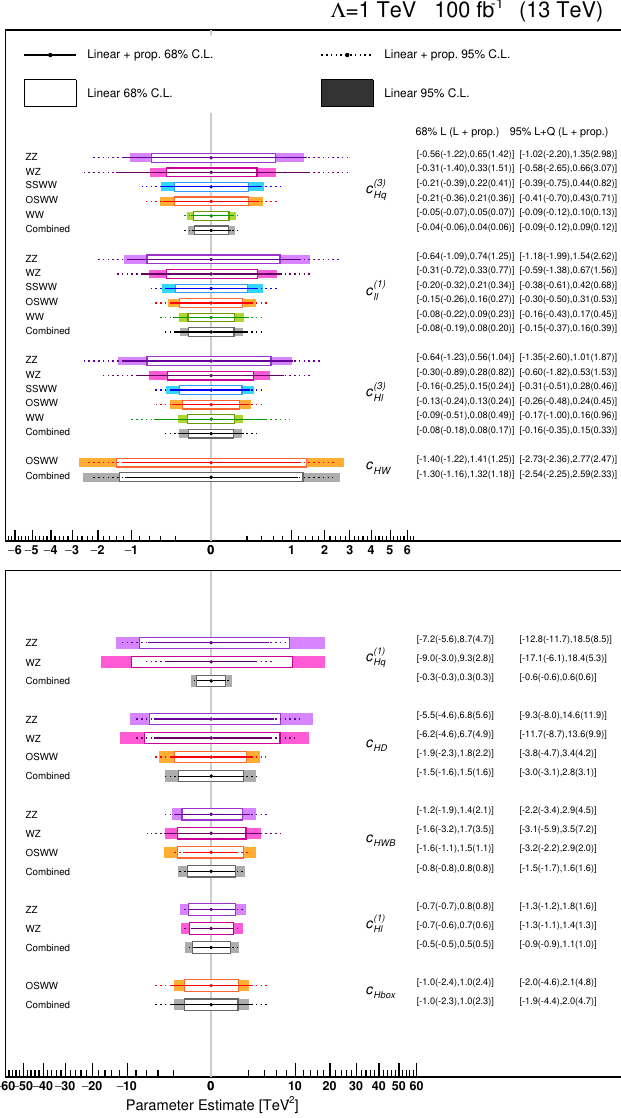
Figure 5 . Impact of linear EFT contributions entering via corrections to the W, Z and Higgs propagators. Solid (dashed) lines indicate the 68% (95%) confidence level intervals obtained in individual fits, including corrections from both vertex and propagator insertions. Open (filled) boxes indicate 68% (95%) confidence level intervals obtained including only vertex